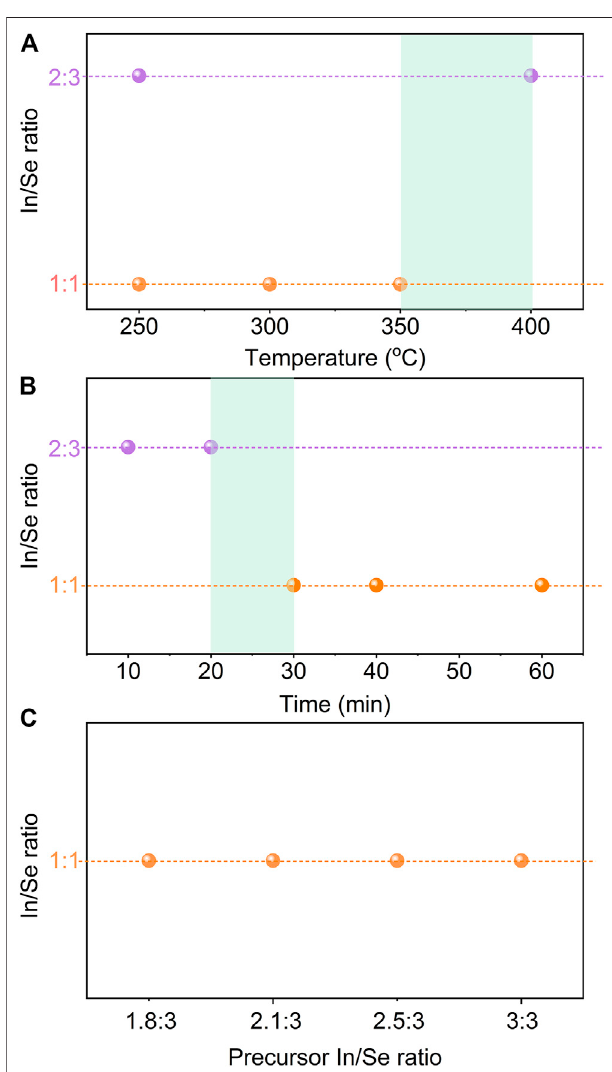
FIGURE 2 | Controlled growth of indium selenides using HPHT growth techniqueunder0.76 GPa.Thegrowthtemperature (A) ,growthdurationtime (B) , and precursor ratio (C) dependence of the stoichiometry of fi nal grown crystals. The shadow rectangle in (A) and (B) indicates the transition region. HPHT, high pressure and high